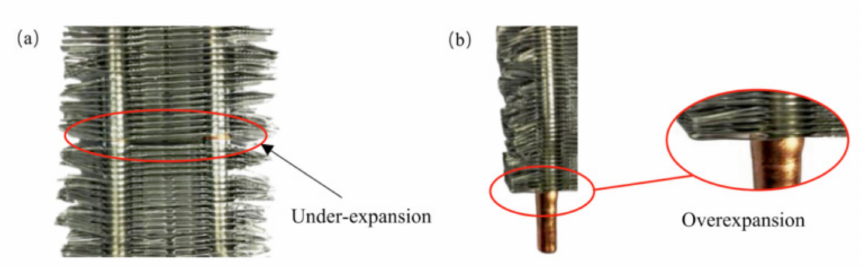
Figure 9. Sample jointed at a hydraulic pressure of ( a ) 14 MPa and ( b ) 20 MPa. Tensile tests were performed on samples formed at the maximum hydraulic pressures ( P max ) of 16, 17, and 18 MPa and cut from hydraulic expansion samples (e.g.,